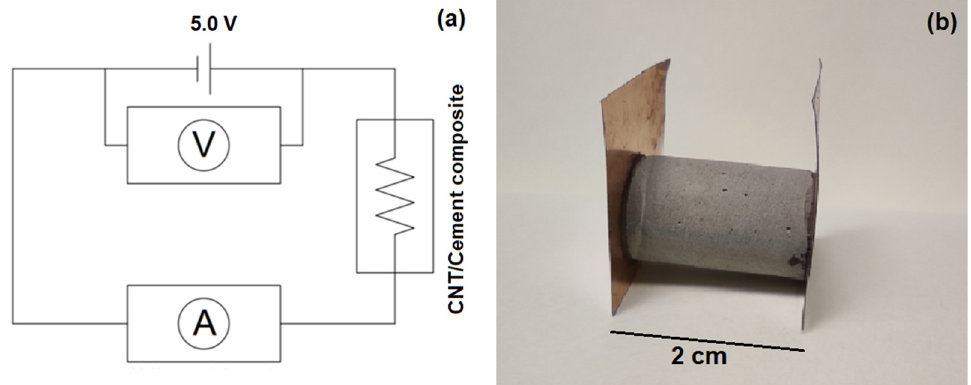
Figure 1. ( a ) Electrical circuit adopted for the electrical resistivity measurements and ( b ) cement paste